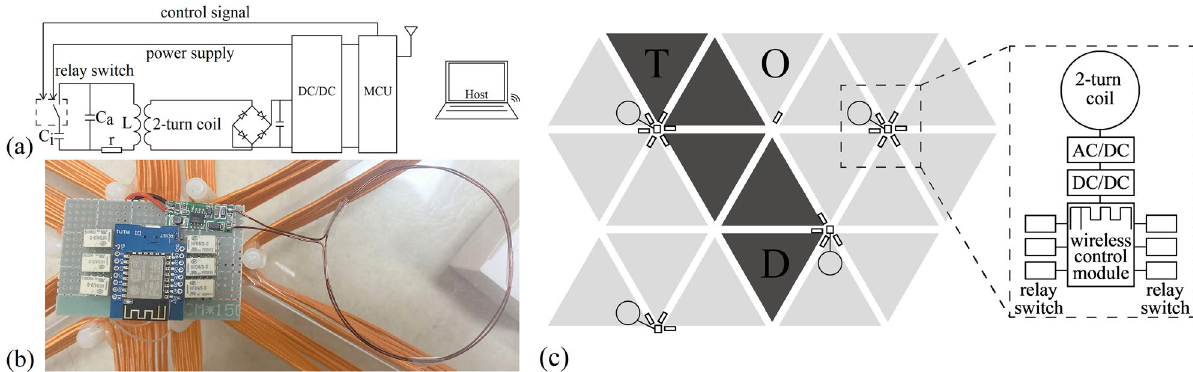
Figure 10. ( a ) The structure of system control. ( b ) Relay control circuit. ( c ) A schematic of the control system. The dashed box on the right is an enlarged view of one control circuit and six relay